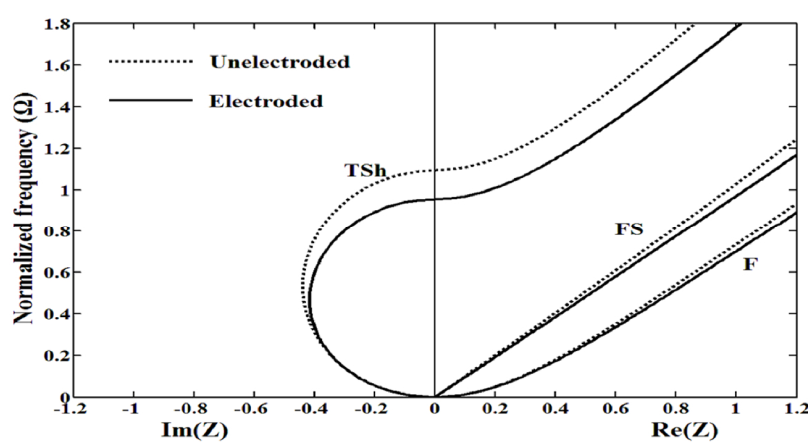
◦ LiTaO 3 plates for lateral field